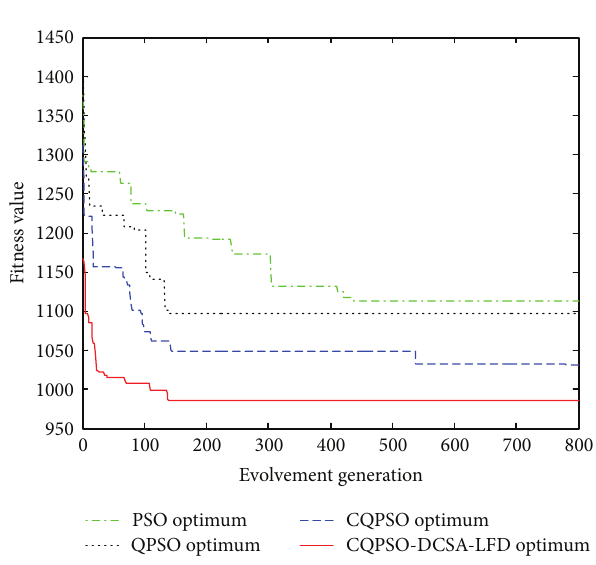
Figure 7: Evolution curves of